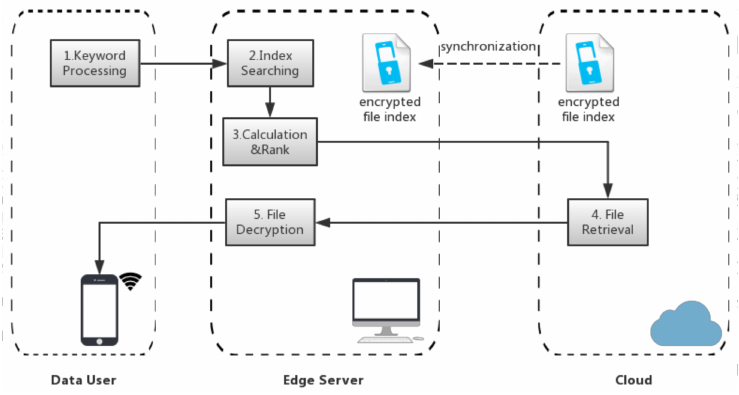
Figure 3. ENSURE’s Process of File Search and